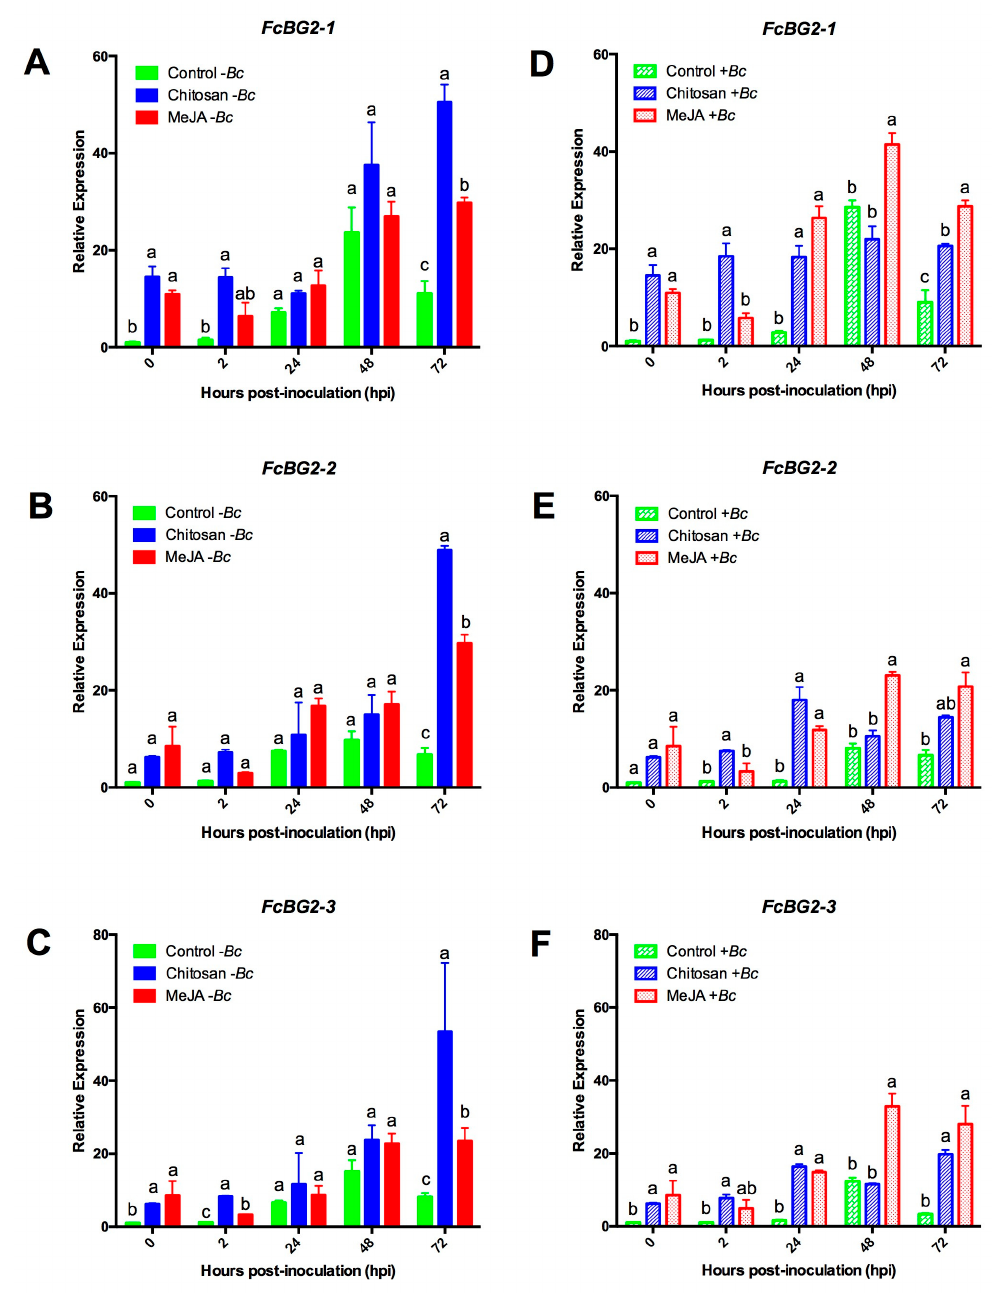
Figure 2. Expression profiles for β -1,3-glucanases-encoding genes ( BG s) in Fragaria chiloensis fruit treated with methyl jasmonate (MeJA) or chitosan at different hours post inoculation (hpi) with or without Botrytis cinerea spores . Changes in the relative expression of FcBG2-1 , FcBG2-2 , and FcBG2-3 in fruit inoculated without (– Bc ) ( A – C ) and with (+ Bc ) B. cinerea spores ( D – F ), respectively, at 0, 2, 24, 48, and 72 hpi. Data were analyzed by ANOVA test and differences between means ± standard error (SE) ( n = 3) were determined using the Tukey test. Different letters indicate significant differences between treatments ( p < 0.05) for each hpi. For experimental details, see the Materials and Methods Section.